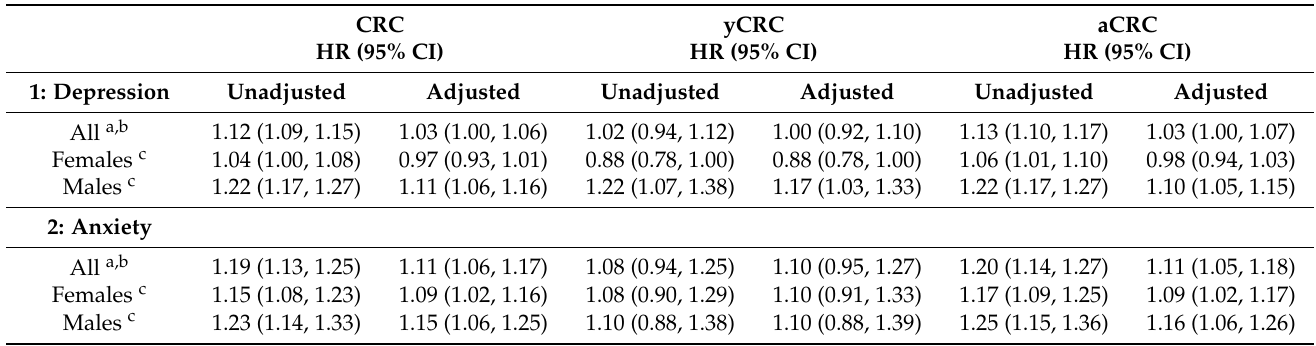
Table 4. Unadjusted and adjusted hazard ratios of depression and anxiety in individuals diagnosed with colorectal cancer (CRC; ≥ 18 years), young-onset colorectal cancer (yCRC; <50 years), average- age-onset colorectal cancer (aCRC; ≥ 50 years) as compared to their respective controls (1985–2017). CRC yCRC aCRC HR (95% CI) HR (95% CI) HR (95%